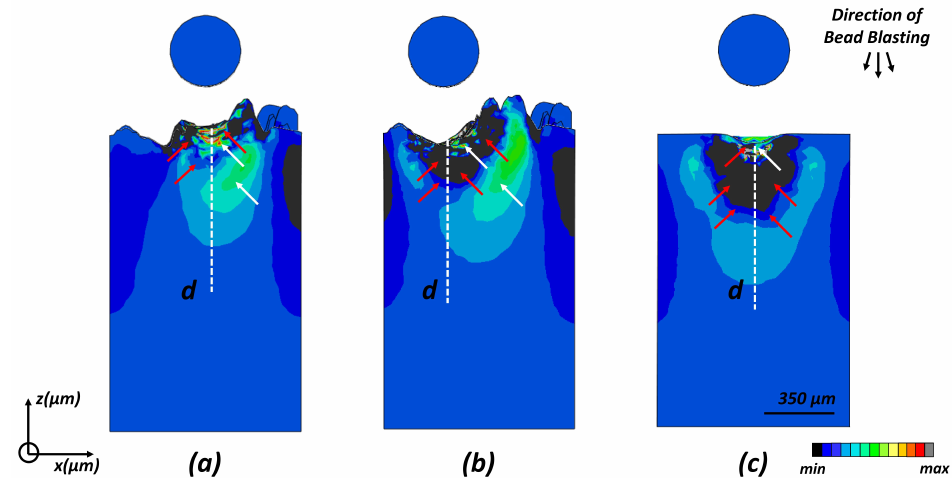
Figure 9. Simulated residual stress profile left after indentation: ( a ) Zone with mean curvature 5.6 10 − 3 µ m − 1 . The (maxima, minima) values of stress field are ( 3.15 10 4 MPa, 3.90 10 4 MPa ) . ( b ) Zone with mean curvature 6.6 10 − 3 µ m − 1 . The (maxima, minima) values of stress field are ( 5.74 10 4 MPa, 4.56 10 4 MPa ) . ( c ) Zone with mean curvature 0, i.e., ideal flat surface. The (maxima, minima) values of stress field are ( 1.38 10 4 MPa, 1.27 10 4 MPa ) . The residual stress field is plotted within a limit of Maximum, Minimum values of 1.013 10 2 to 1.016 10 3 MPa. Elements having stress above this range are colored grey and below this range are colored black. The white and red arrows indicate positive and negative residual stress values, respectively.